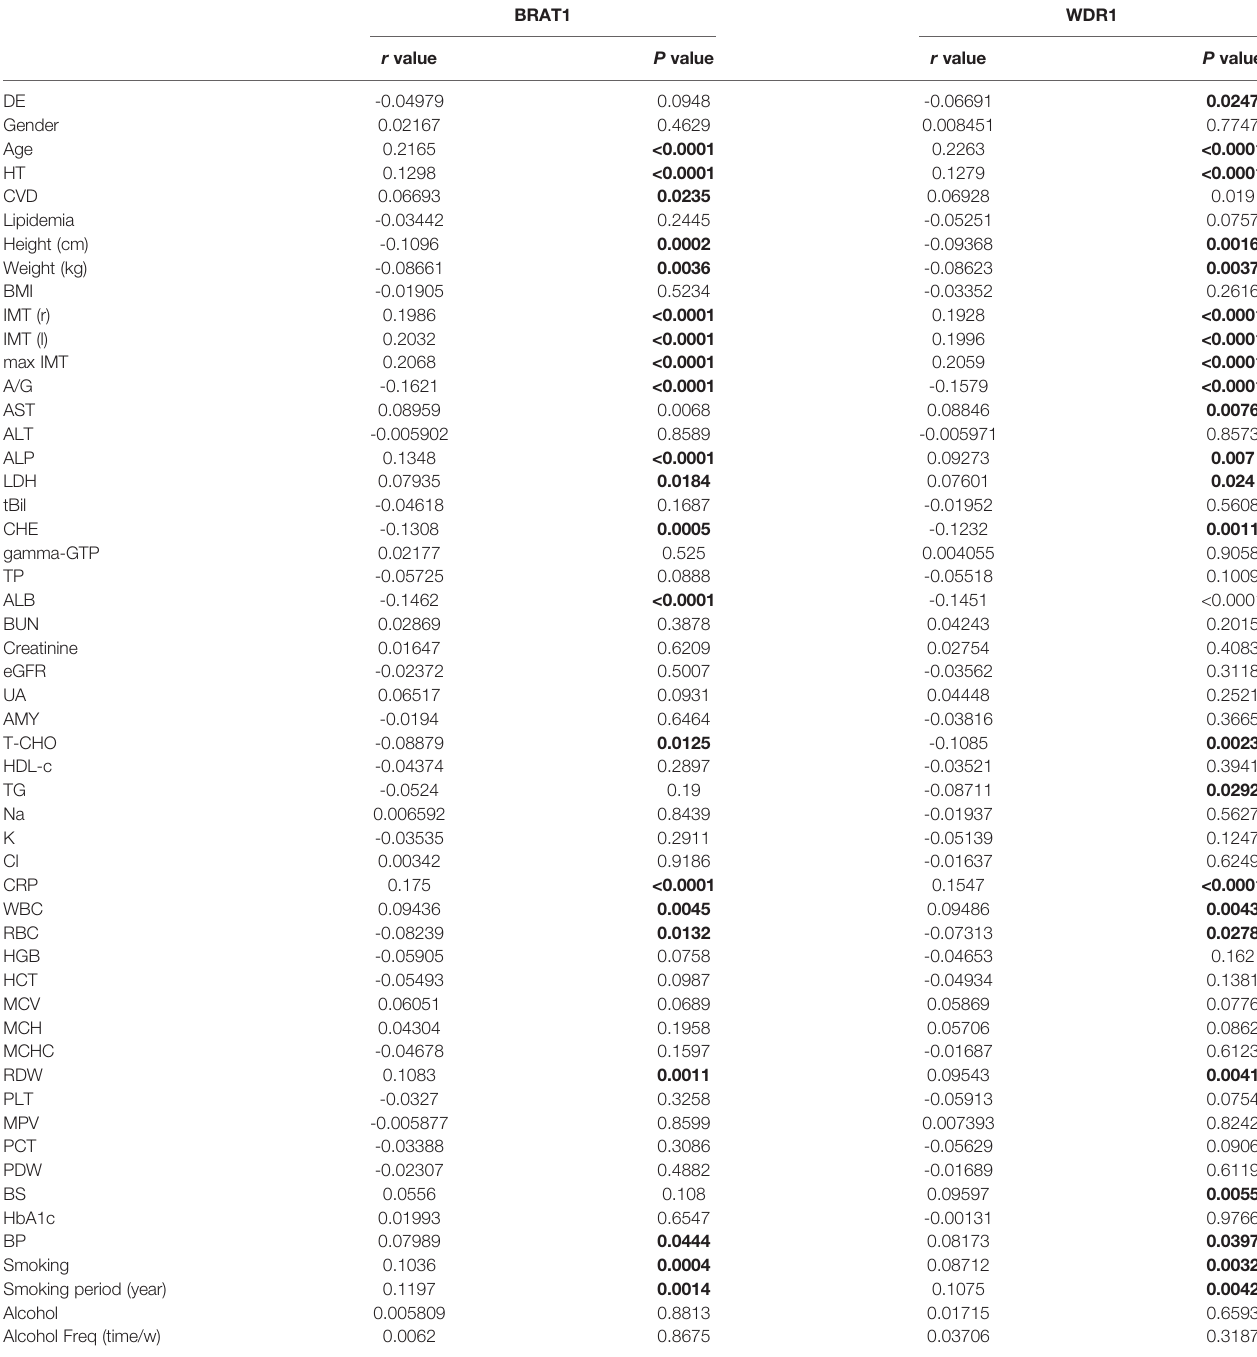
TABLE 2 | Correlation analysis between serum BRAT1-, and WDR1-Ab levels and the indices in HDs, TIA, aCI or oCI patients. BRAT1 WDR1 r value P value r value P value